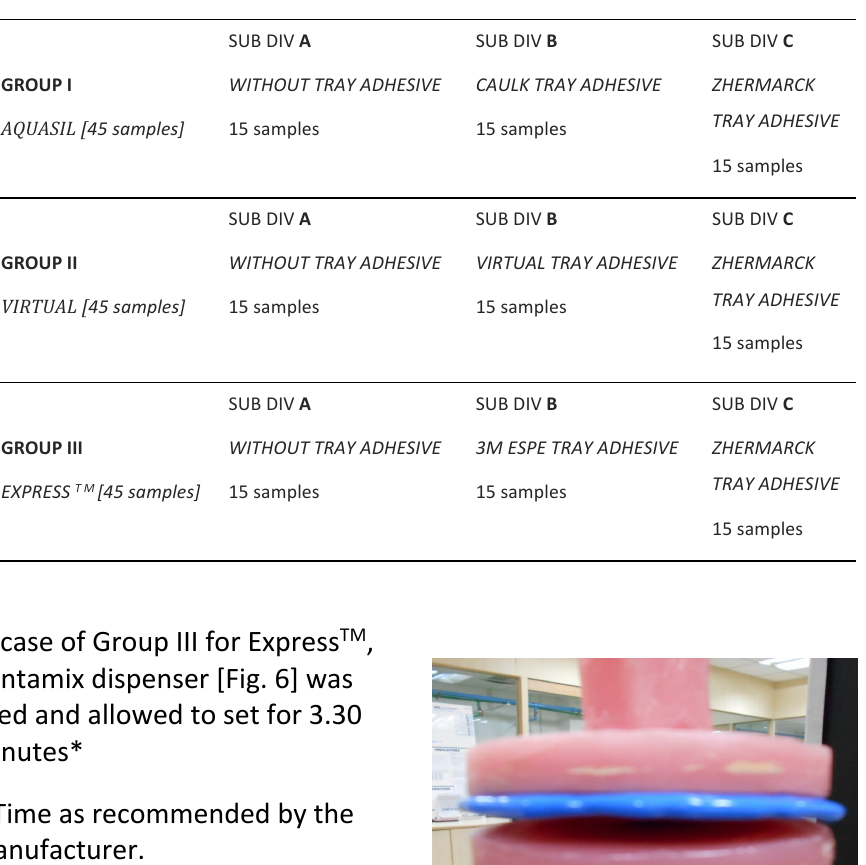
Table 1. Grouping of selected impression materials with its subdivisions based on tray adhesives used.